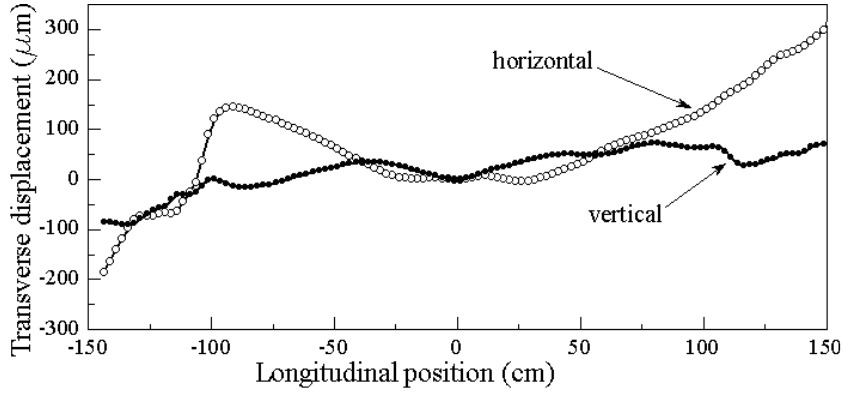
FIG. 7. Measured vertical and horizontal field lines in the TEL-1 main solenoid at 40 kG.